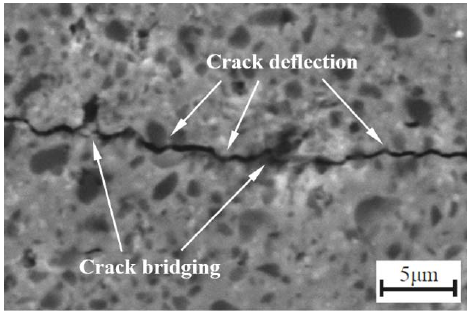
Figure 6. SEM micrograph of crack propagation of TiC 0.7 N 0.3 ‐ HfC ‐ WC ‐ Ni ‐ Mo cermet tool materials.